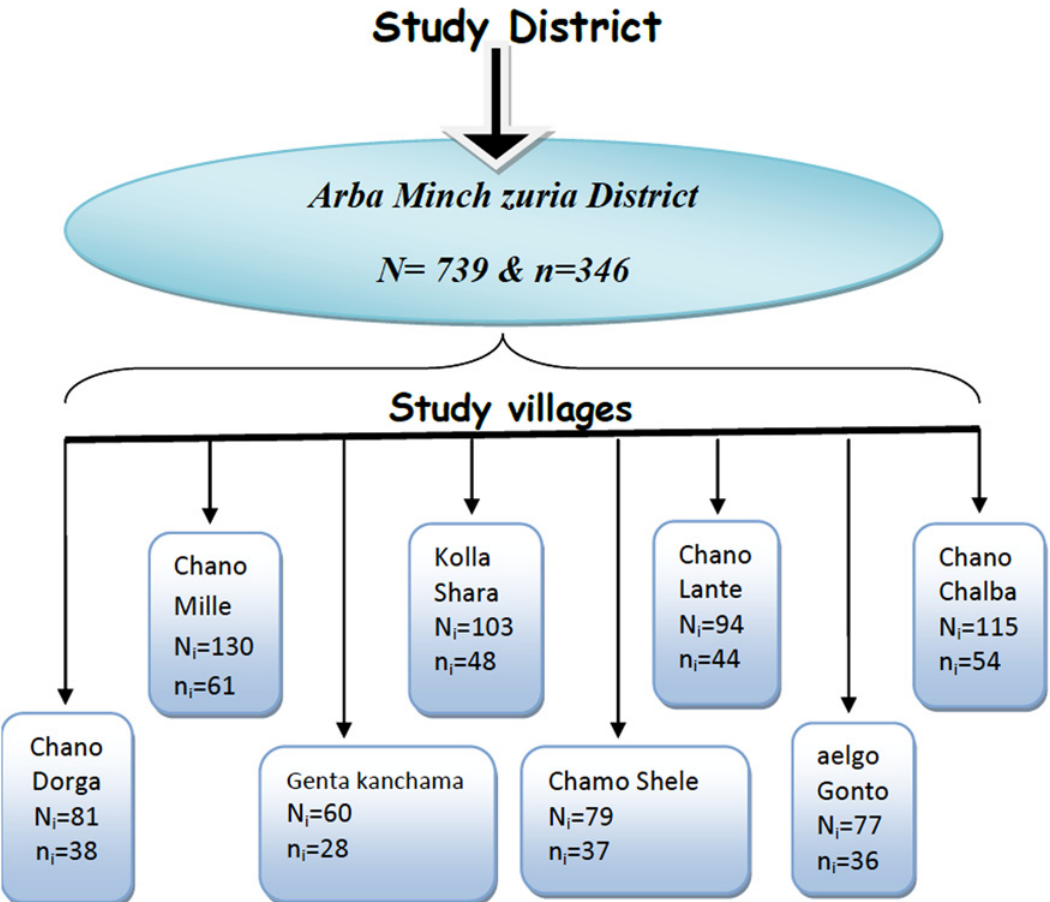
Fig 1. Flow chart indicating the sampling procedure for a study conducted on asymptomatic malaria parasitemia among pregnant women in rural surroundings of Arba Minch, Southern Ethiopia, between April and June